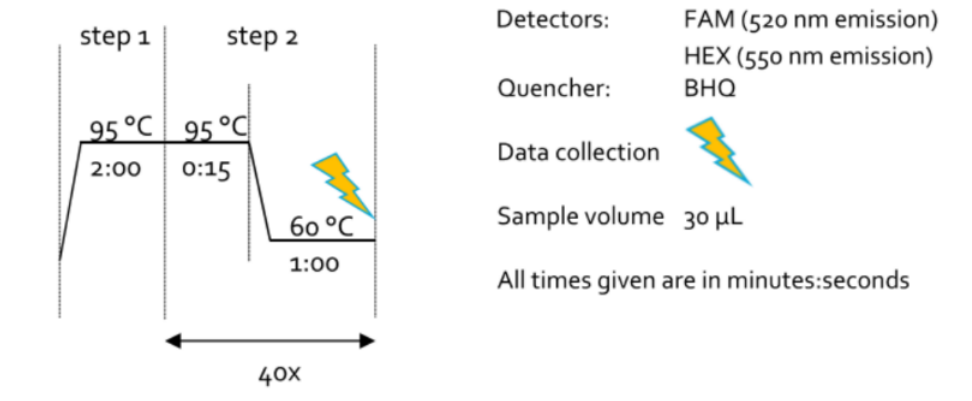
Figure 2 . Temperature scheme of